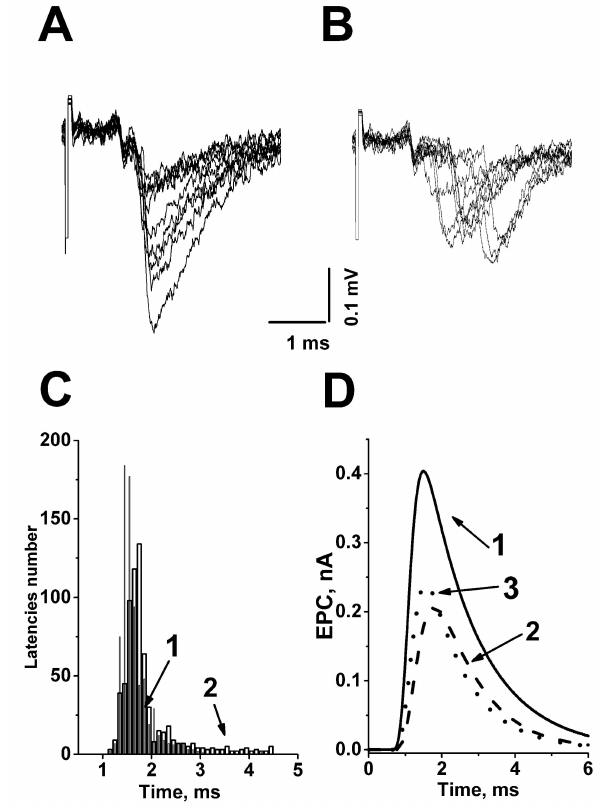
Figure 3. Exogenous ACh desynchronizes the quantal secretion in the frog neuromuscular junction. ( A ) Superimposed extracellular recordings of action potentials of the nerve terminal and uniquantal end-plate potentials under low extracellular Ca 2+ concentration in control in the distal part of long nerve terminal; ( B ) the superposition of uniquantal EPCs in the same synapse after ACh (10 µ M) addition in the bathing solution; ( C ) histogram illustrating the distribution of synaptic delays